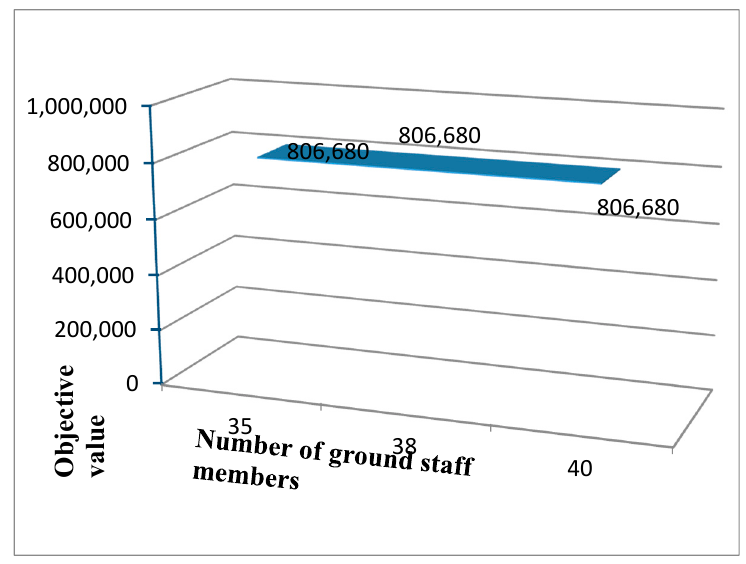
Figure 7. Simulation analysis of the variation in the number of ground staff members.